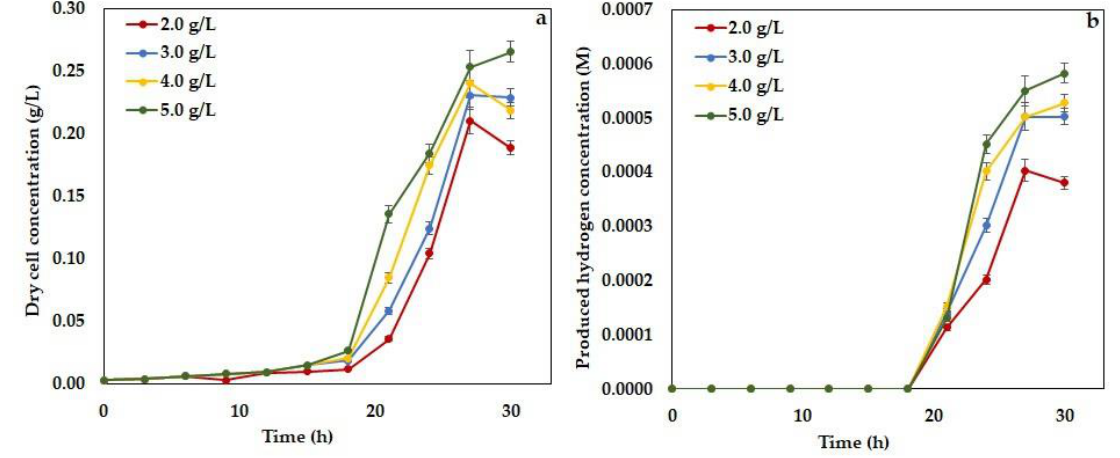
Figure 10. Experimental time histories of dry cell concentration ( a ) and hydrogen concentration ( b ) with initial 50% H 2 in reactor headspace at different substrate concentration.